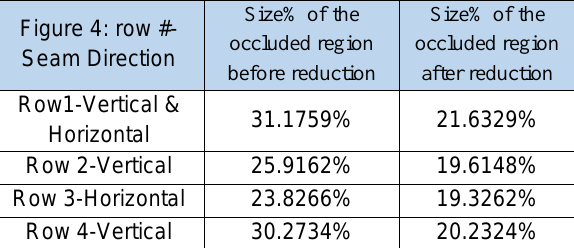
Figure 4 , before and after using the seam carving method. Table 1. The size of the missing regions to the whole images in Figure 4 before and after reduction using seam carving approach. Figure 4: row #-